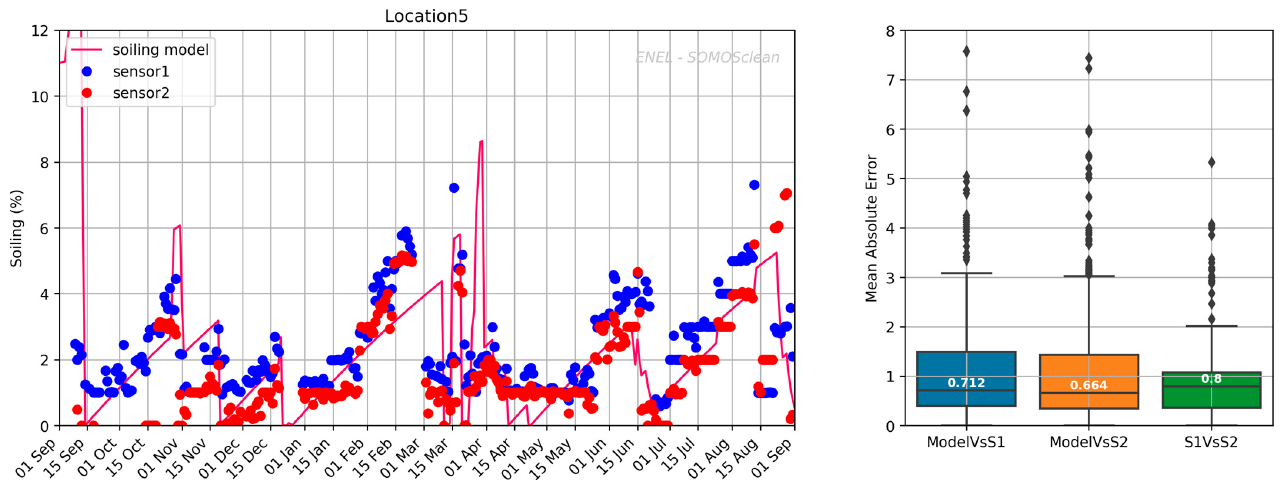
Figure A4. Soiling data from the power plant at location 4.